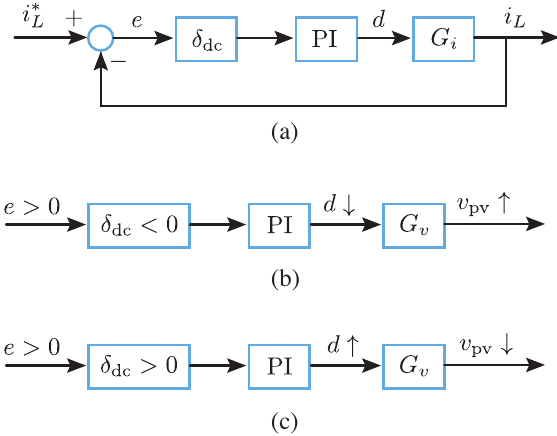
Figure 6. Control block diagram ( a ) and MPP tracking situations: ( b ) to the left of the MPP; and ( c ) to the right of the